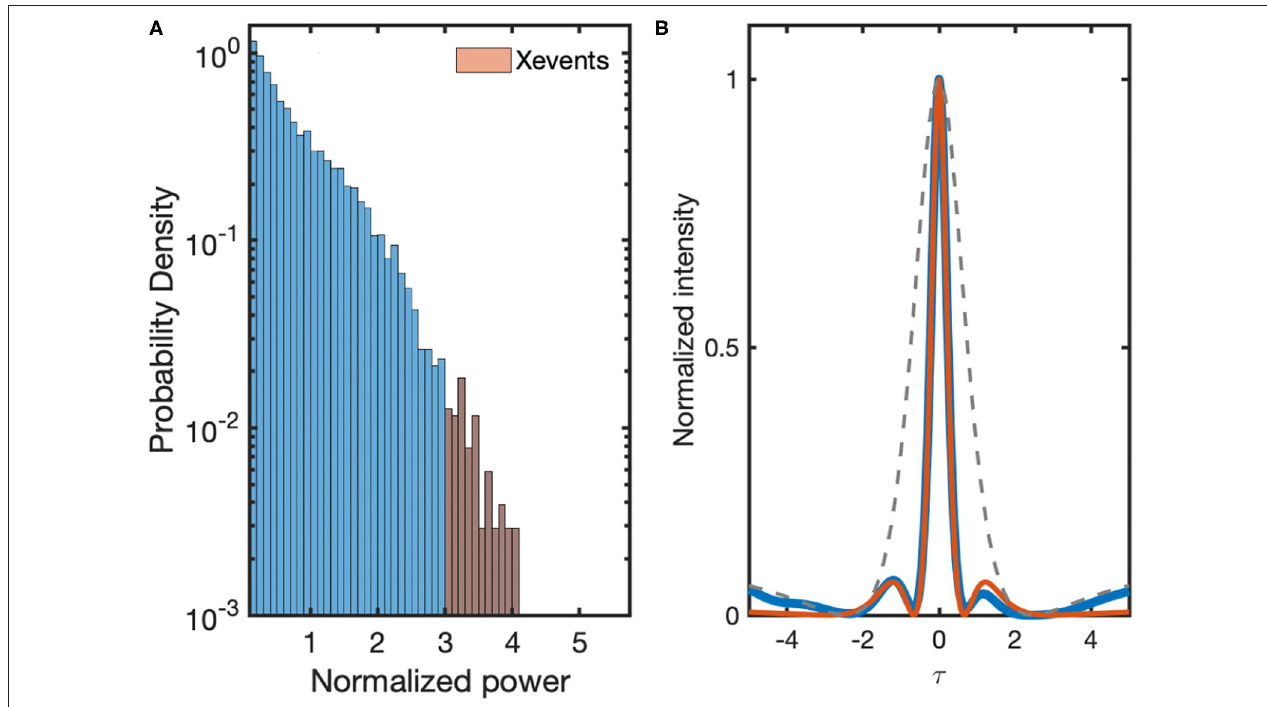
FIGURE 4 | Probability density function (A) of intensity bursts observed in the spatiotemporal chaos of Equation (3) for α correspond to the values above the characteristic wave height. (B) Mean intensity profile from the five larger pulses and the result of the best fit of this profile with Equation (8). Xevents in (A) correspond to the bursts with peak values above twice the significant wave height. This height is defined as the average value of the largest 1/3 burst.